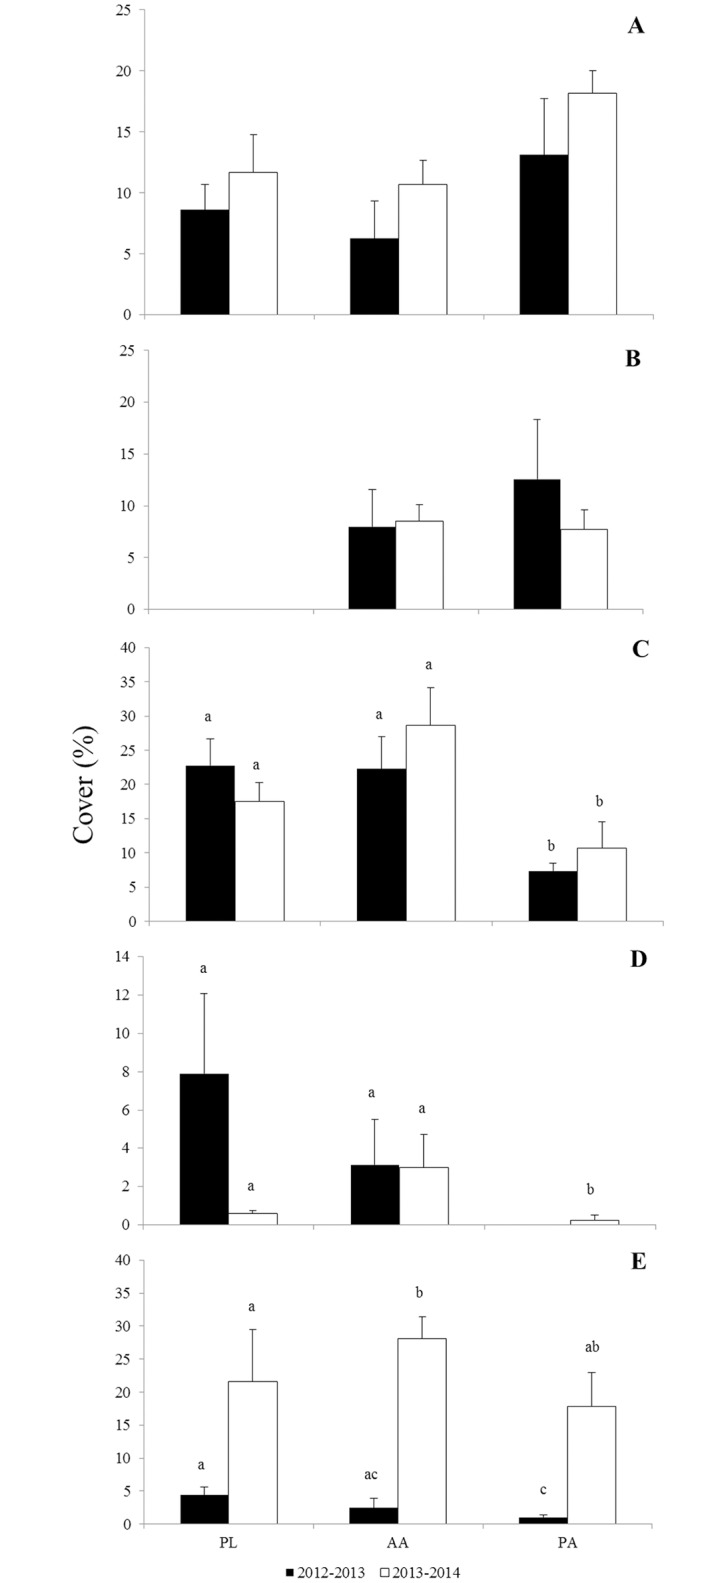
Cover (%) of main organisms at the sites (PL, AA and PA) after one year of colonization.A = Ascidians; B = Bryozoans; C = Crustose coralline algae; D = Fleshy algae; E = Turfs. Different letters above bars are used to indicate statistically differences (p< 0.05) of cover of organisms obtained through pair-wise tested after the PERMANOVA analysis.